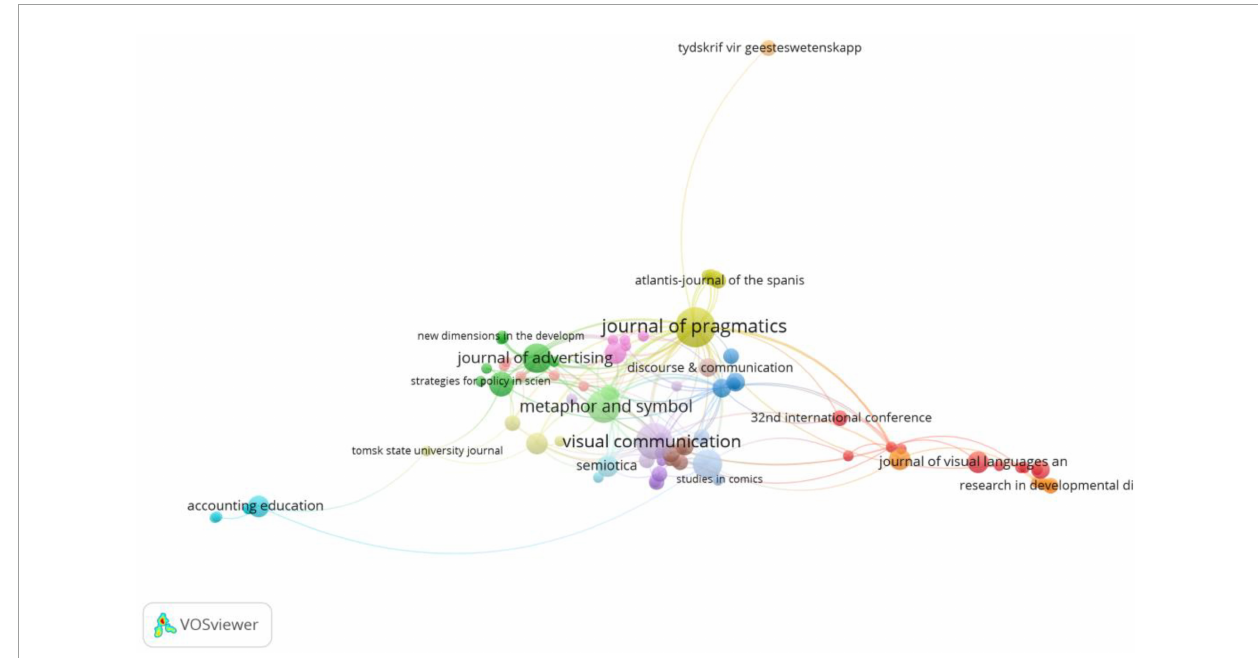
FIGURE4 Citation analysis by sources with all sources in account (min number of citations of a source = 1; visualization by weight of documents).